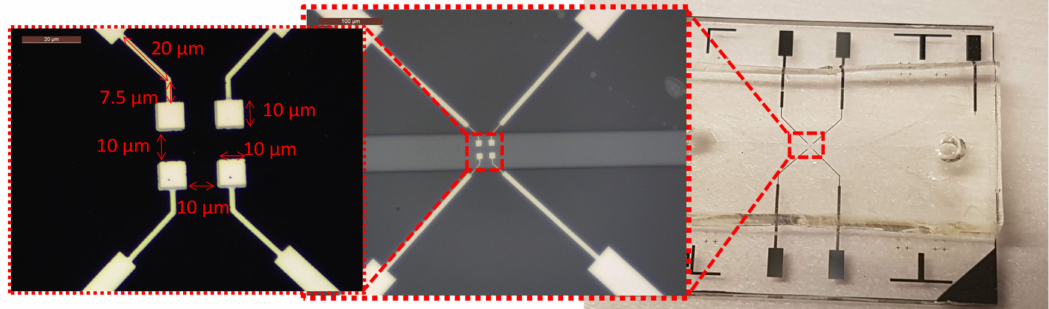
Figure 6. Image of the built biosensor with electrodes and connection track dimensions. From right to left: Complete biosensor with electrical pads and microfluidic-macrofluidic interface; Microfluidic channel and electrodes; Electrodes and connection track